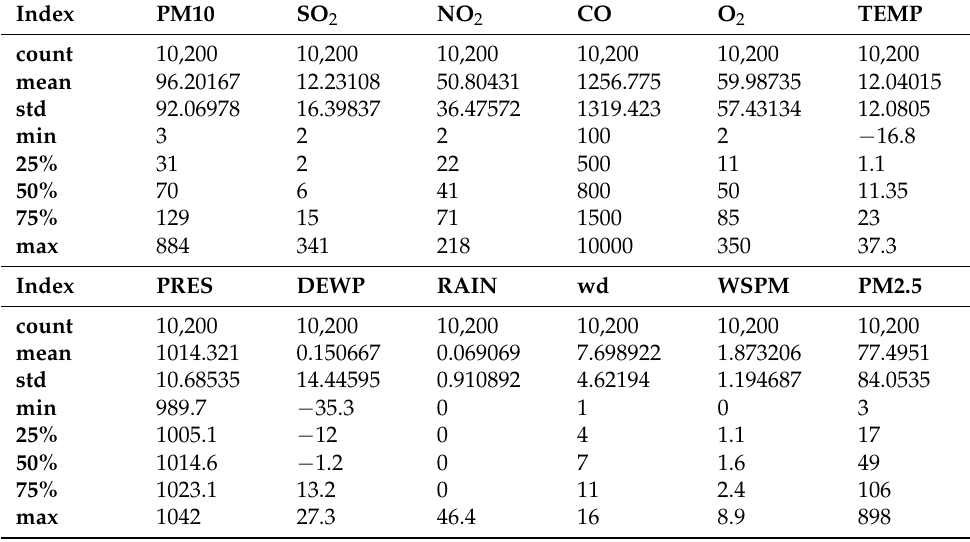
Table 1. Statistical info of the